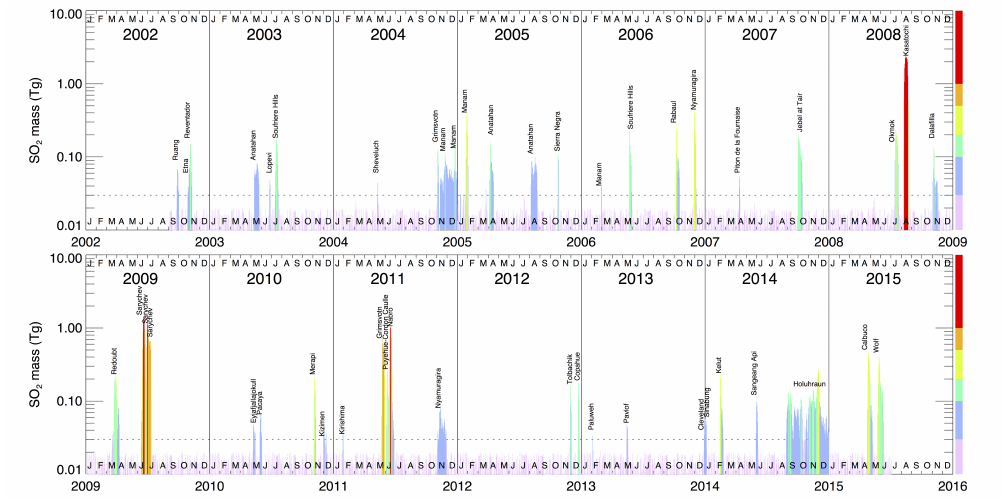
Figure 21. SO 2 total masses showing volcanic activity during 2009 as detected by the AIRS Earth Observation satellite. Note the strong emissions from Sarychev Peak lasting ∼ 4 weeks.